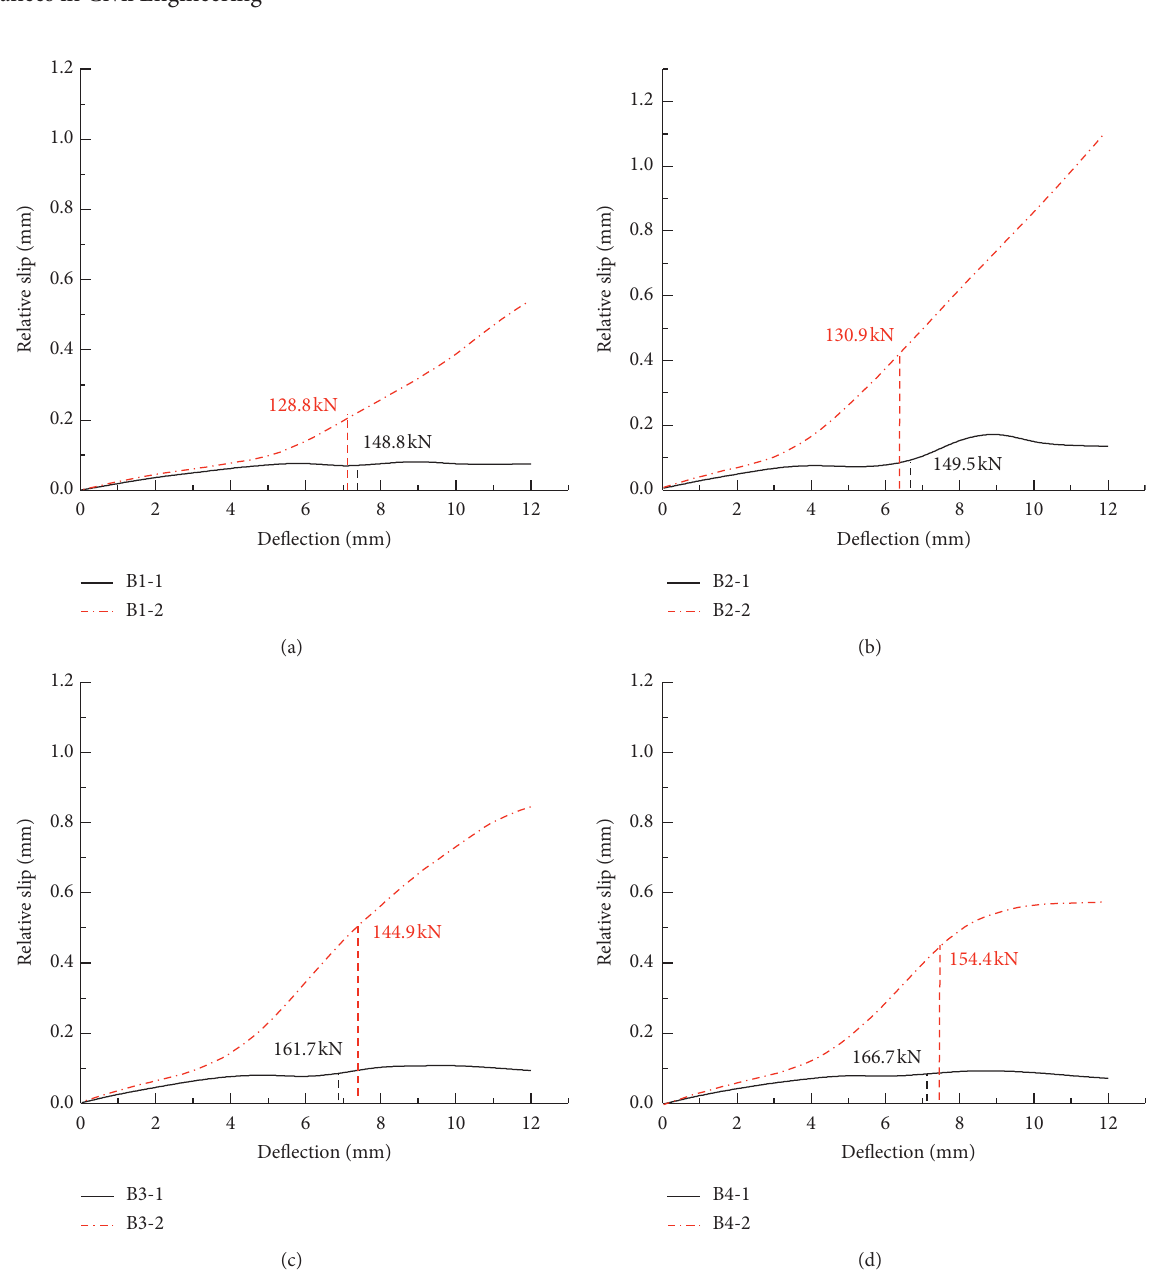
Figure 5: Relative slip of the C-ITZ. (a) B1-1and B1-2. (b) B2-1 and B2-2. (c) B3-1and B3-2. (d) B4-1 and B4-2. Table 8: Maximal relative slip in C-ITZ. Model